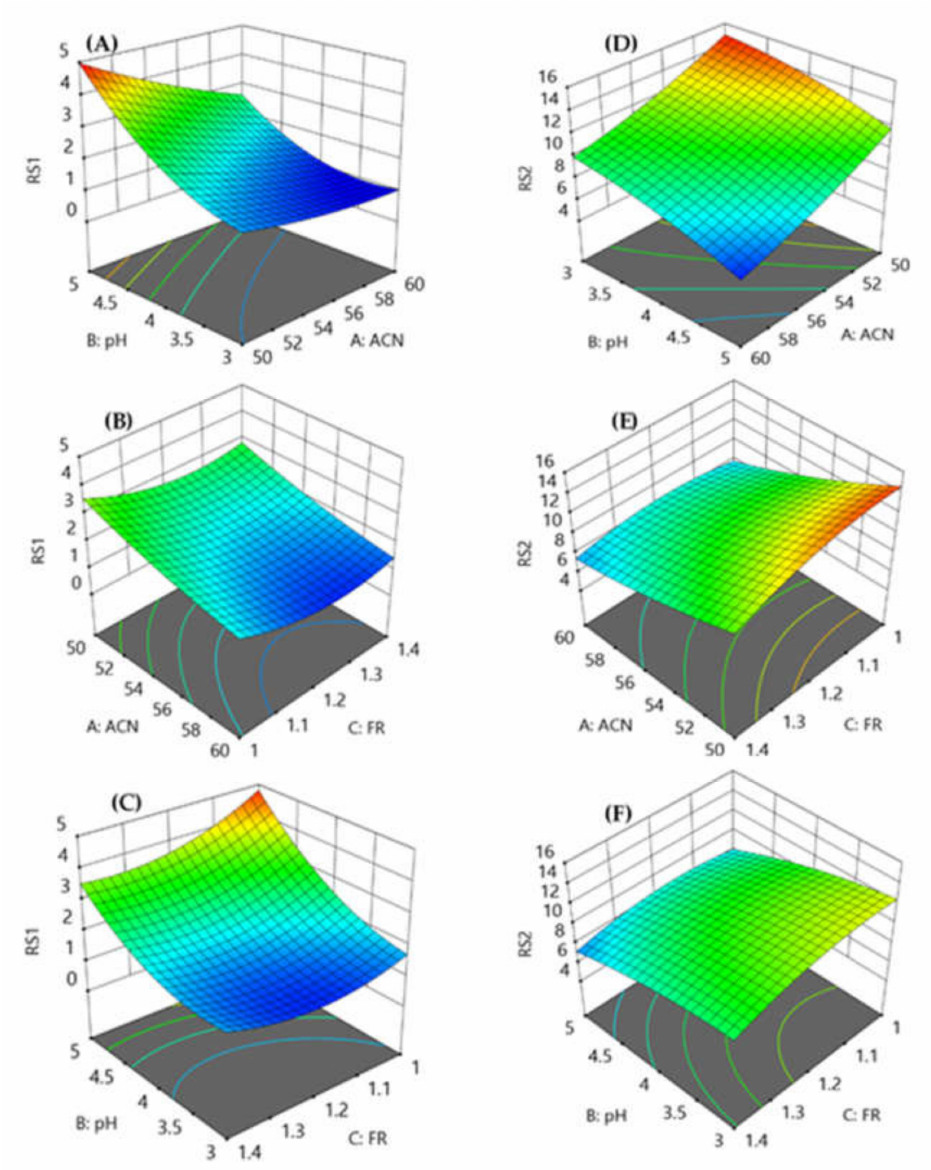
Figure 2. Response surface models showing the effect of percentage of acetonitrile, pH of the mobile phase and flow rate on the resolution between VLG to TNG ( A–C ) and TNG to RGE ( D–F ). All response models fit into the quadratic polynomial model (Table 2) and Figure 3 shows that predicted versus actual resolution values are close to each other and on the diagonal line, demonstrating that the model adequately fits the data. Furthermore, to develop a rapid HPLC method with good resolution and peak symmetry, resolution between the first two peaks was set at a target value of 2.7, and resolution between the second and third peaks was set at a target value of 6.5 in the design space. Finally, the optimal chromatographic condition selected by the design space with desirability value of 0.996, which is close to 1, was acetonitrile 58%, pH 4.9, and flow rate 1.2 (Figure